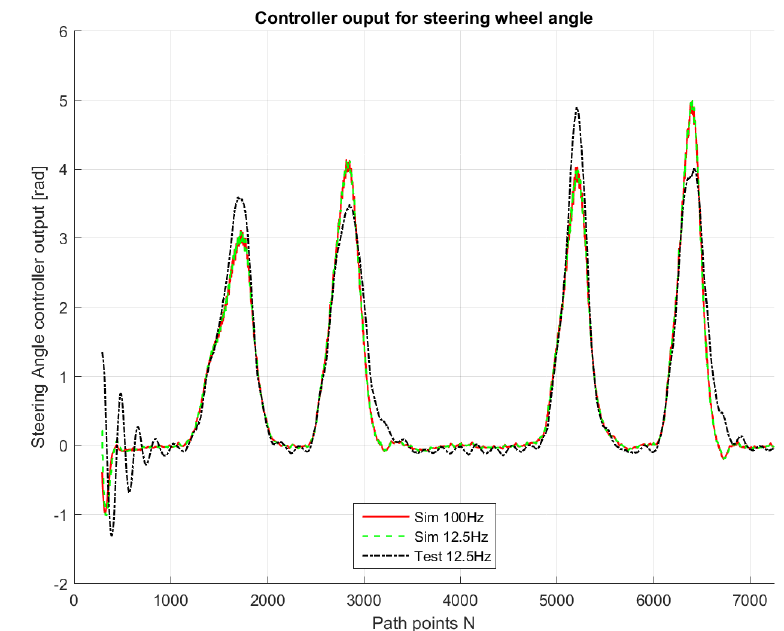
Figure 10. Controller output for simulations and test drive.